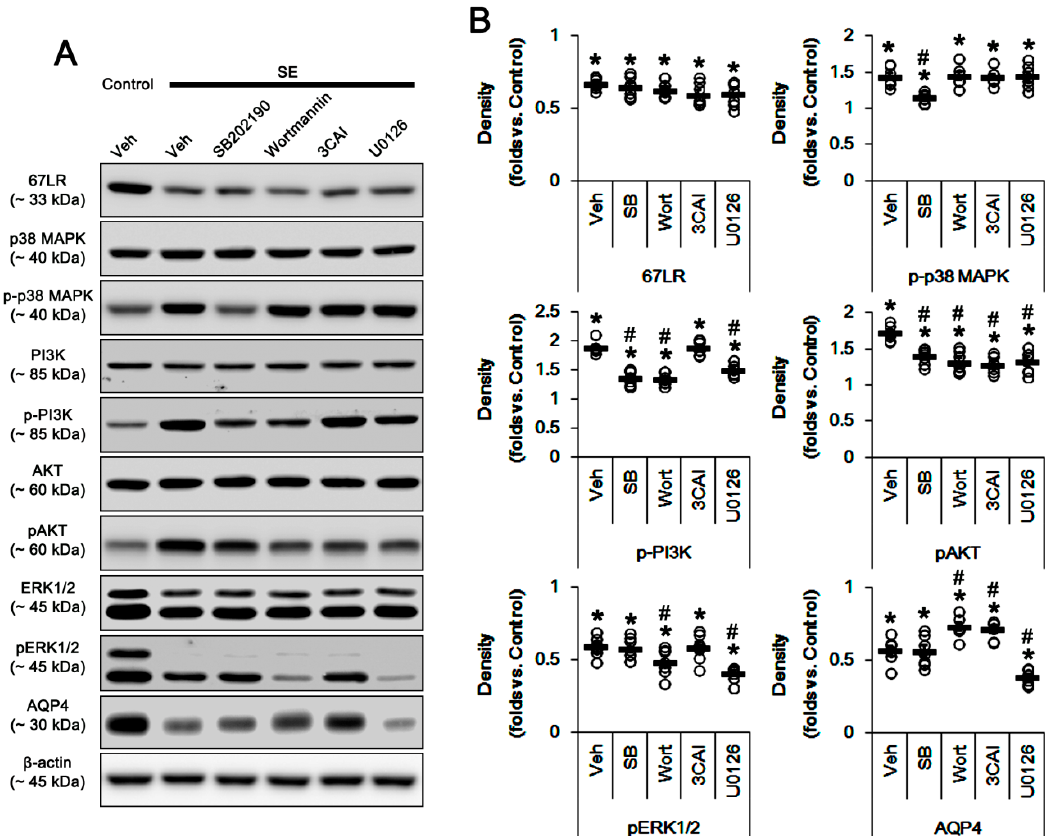
Figure 5. Effects of kinase inhibitors on protein phosphorylations and AQP4 expression in the PC following SE. SE decreased 67LR and AQP4 expressions and pERK1/2 level in the PC, while it increases p38 MAPK, PI3K, and AKT phosphorylations. SB202190, wortmannin, 3CAI, and U0126 do not affect 67LR expression following SE. SB202190 attenuates p38 MAPK and PI3K/AKT phosphorylations. Wortmannin, 3CAI, and U0126 do not affect p38 MAPK phosphorylation. Wortmannin and U0126 reduce PI3K/AKT and ERK1/2 phosphorylations. 3CAI inhibits only AKT phosphorylation. Wortmannin and 3CAI mitigate AQP4 expression, while U0126 deteriorates it. ( A ) Representative Western blot images for expressions and phosphorylations of 67LR, p38 MAPK, PI3K, AKT, ERK1/2, and AQP4. ( B ) Quantitative values (mean ± S.E.M) of the Western blot data concerning expressions and phosphorylations of 67LR, p38 MAPK, PI3K, AKT, ERK1/2, and AQP4 ( n = 7, respectively). Open circles indicate each individual value. Horizontal bars indicate the mean value. Error bars indicate S.E.M. Significant differences are * ,# p < 0.05 vs. control (non-SE) animals and vehicle, respectively (one-way ANOVA).